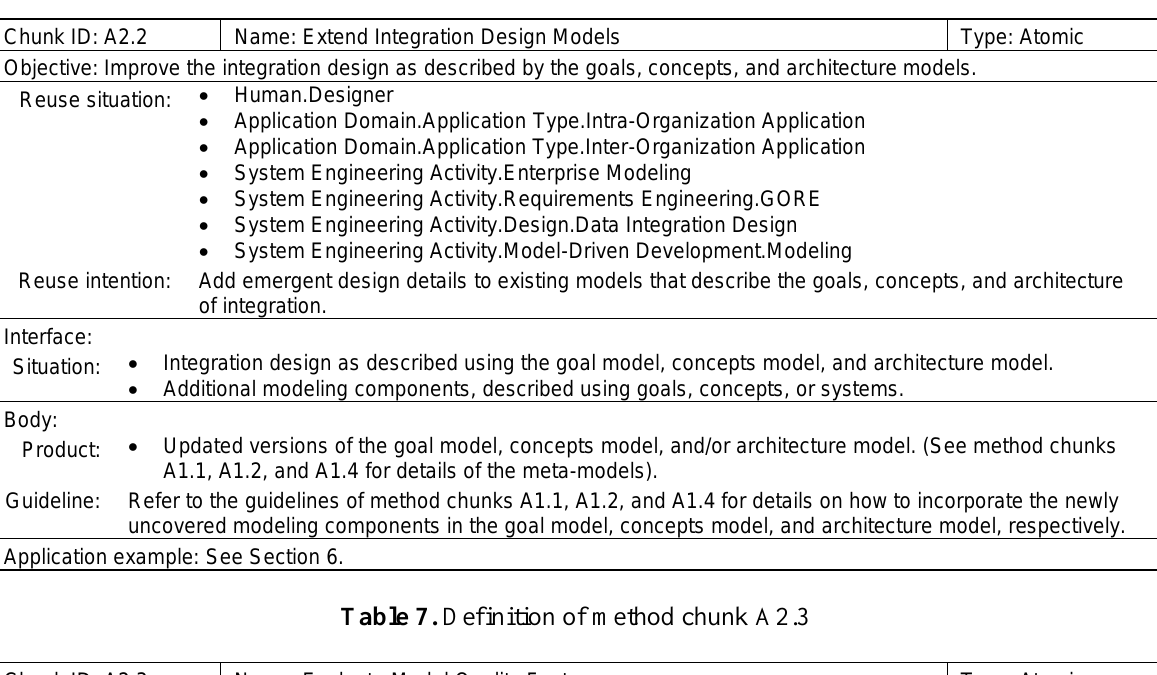
Table 6. Definition of method chunk A2.2